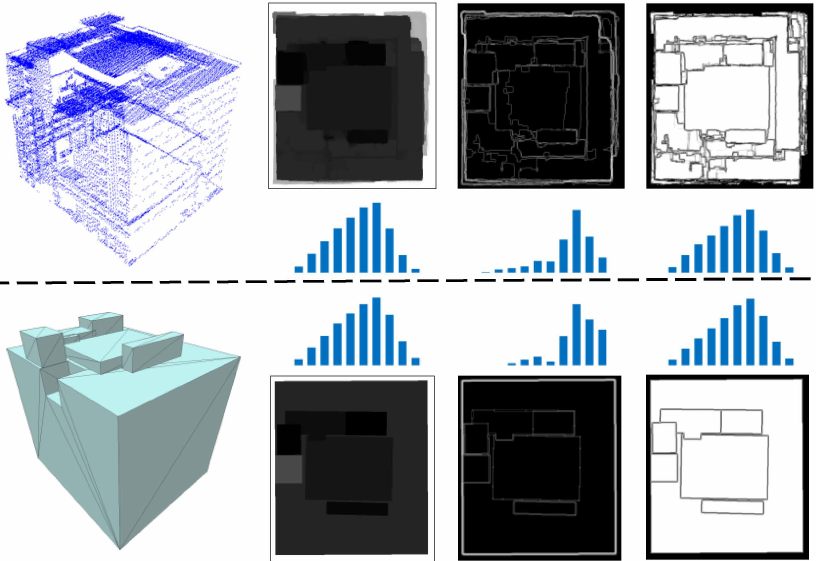
Figure 7. Consistent encoding of point cloud ( top ) and building model ( bottom ). 1st row: original data; 2nd–4th rows: results of height, edge and planarity features and their corresponding spatial